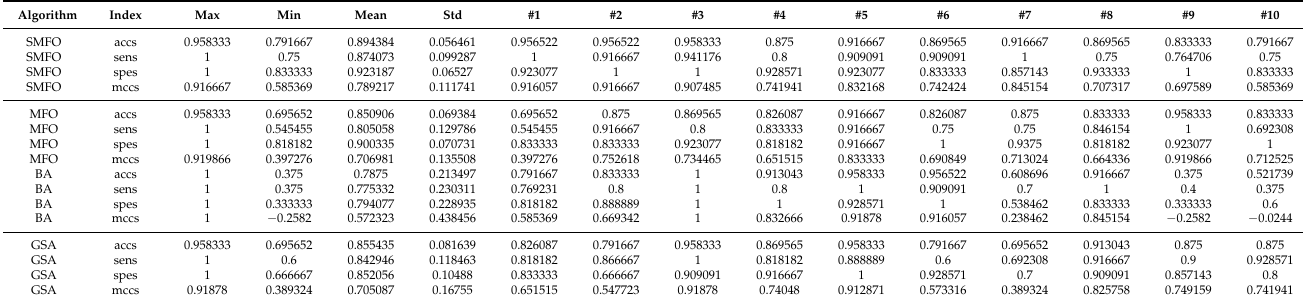
Table A2. SMFO and other comparison algorithms 10-fold cross-validation